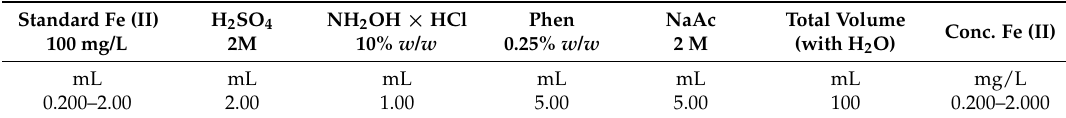
Table 1. Preparation of iron (II) calibrating